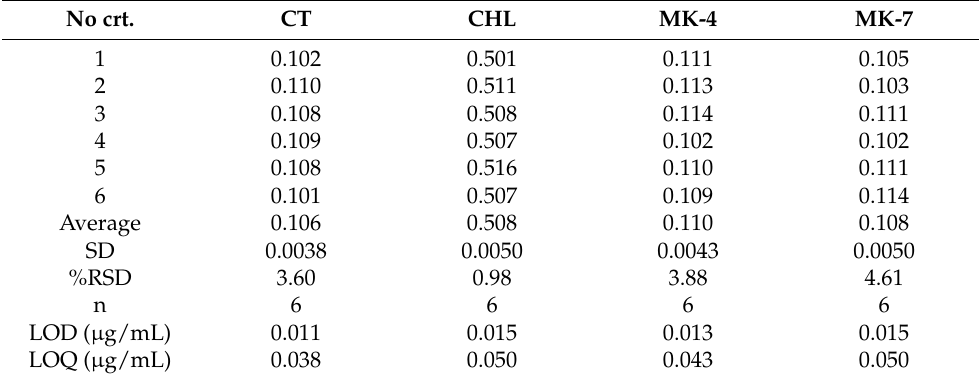
Table 2. Limit of detection (LOD) and limit of quantification (LOQ).